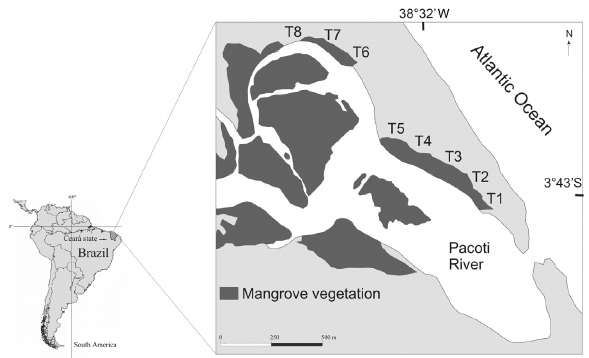
Fig. 1. – Map indicating the sampling area at Pacoti River man- grove, Ceará state, northeast Brazil, with location of sampling transects T1 to